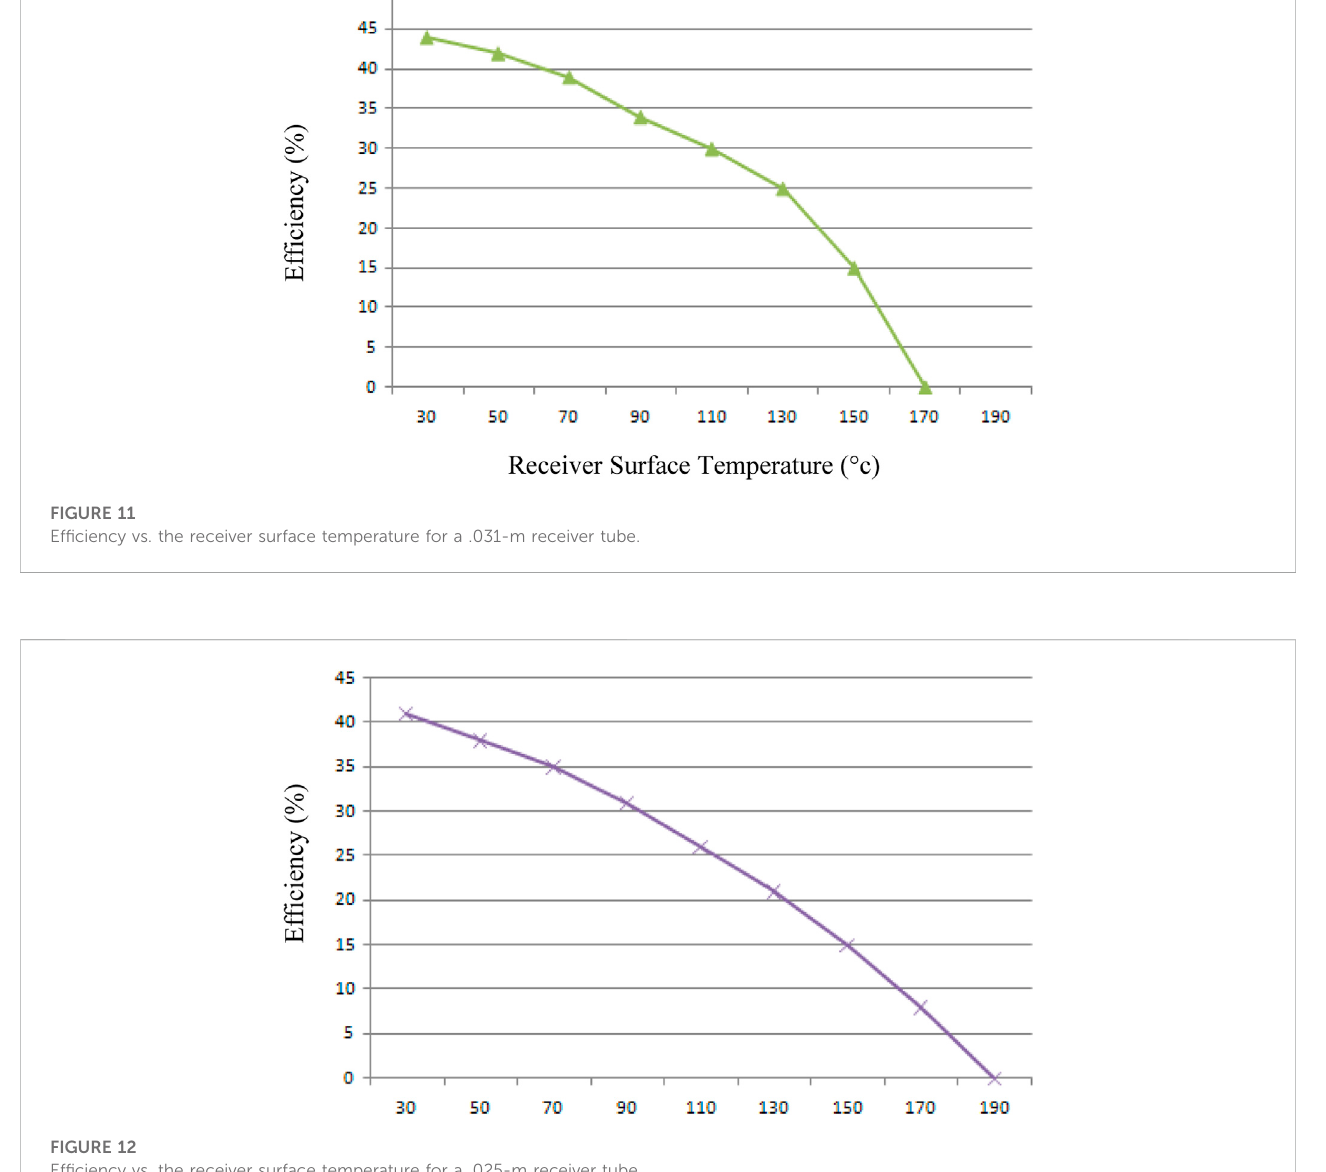
Ef fi ciency vs. the receiver surface temperature for a .025-m receiver